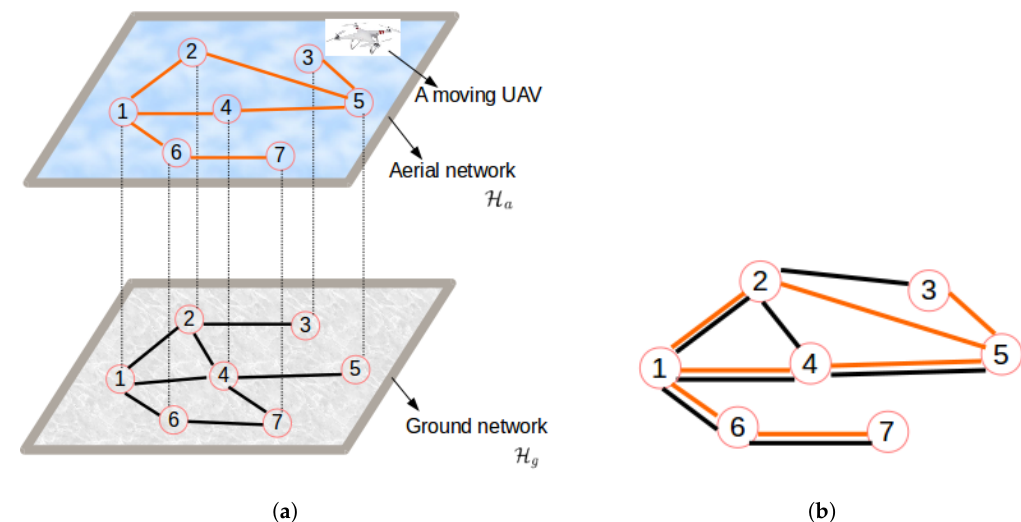
Figure 2. Terrestrial, airborne, and hybrid networks. ( a ) Physical topology; ( b ) conceptualized